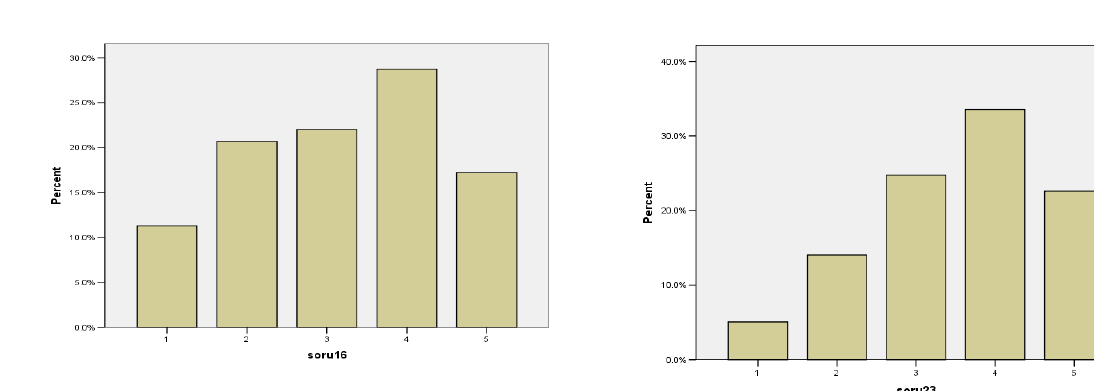
Q28: Should accounting education value ethical